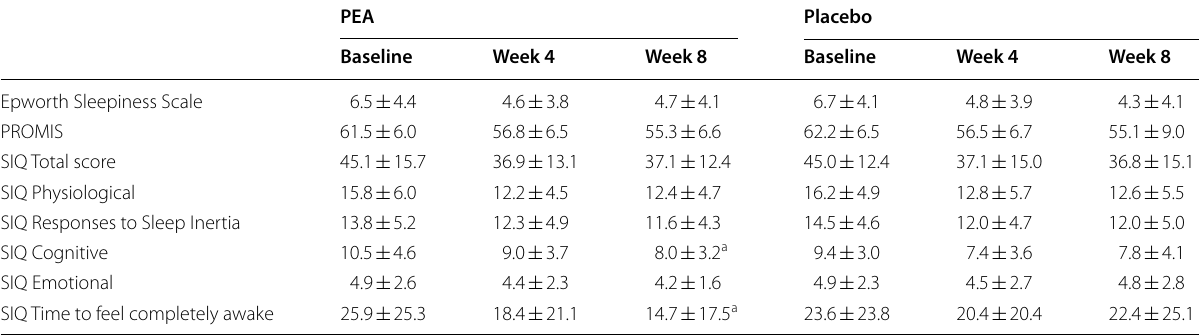
N.B. Data presented as mean standard deviation; a significant difference between groups at p < 0.05; PEA Palmitoylethanolamide, PROMIS Patient Reported ± Outcomes Measurement Information System, SIQ The Sleep Inertia